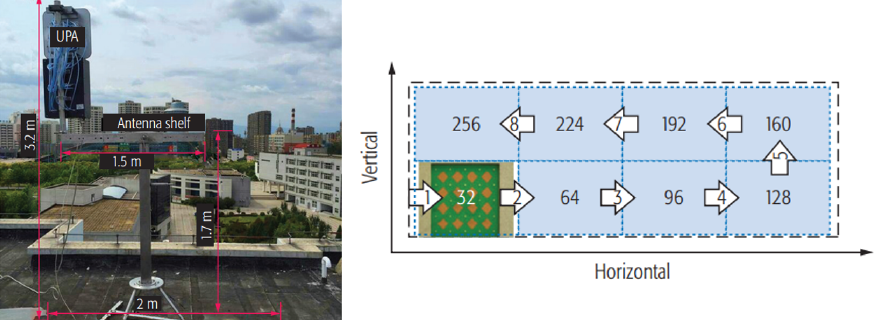
Figure 9. The antenna shelf and massive MIMO measurement principle diagram of 3D MIMO antennas from 32 to 256 at Tx